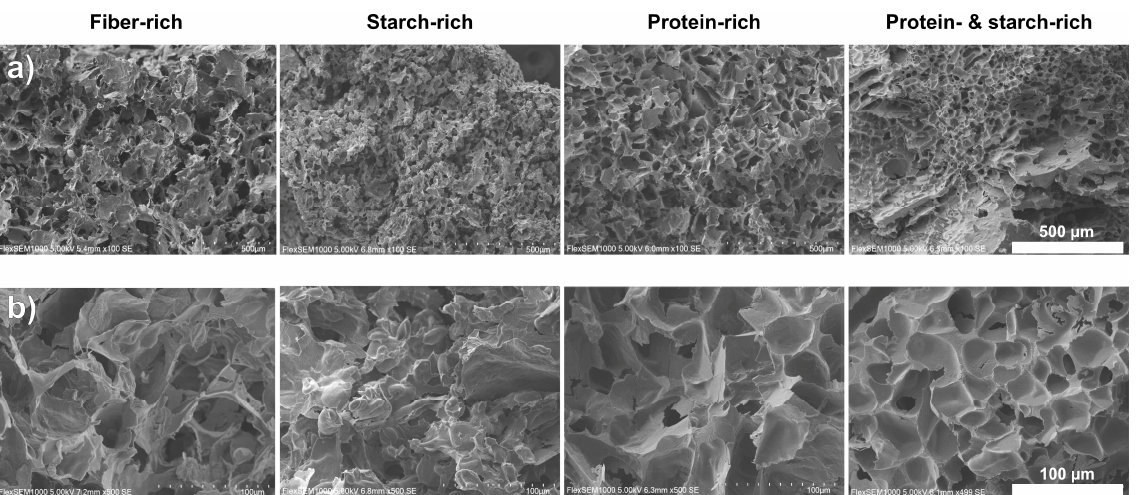
10 of 15 Figure 4. Images of the two samples that differed most after compression: ( a ) protein-rich recipe with grid infill pattern compressed from the top (PGT) and ( b ) starch-rich recipe with honeycomb infill pattern compressed from the side (SHS). 3.8. Scanning Electron Microscopy The scanning electron microscopy (SEM) micrographs revealed that for all samples, the microstructure was strongly affected by freezing and freeze-drying. This could be seen